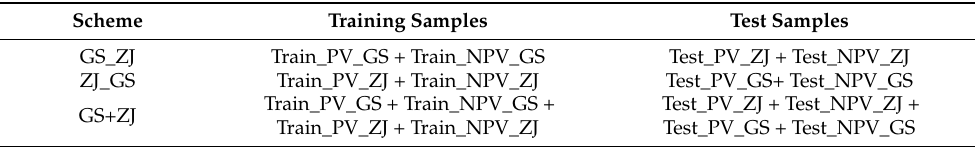
Table 4. Three classification schemes under evaluation in this study. Scheme Training Samples Test